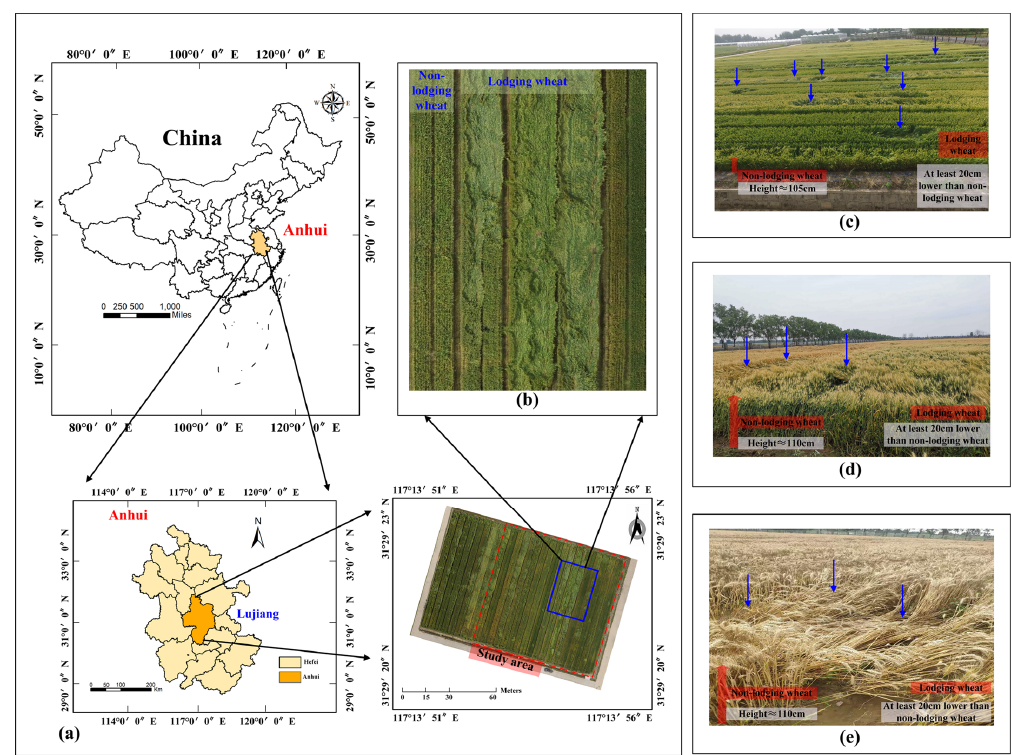
Figure 1. Location of UAV imaging area, study site and lodging samples: ( a ) study site; ( b ) partially enlarged display of the wheat field; the close-up maps of lodging and healthy wheat in ( c ) flowering, ( d ) filling and ( e ) maturity. The field indicated by the blue arrow is the lodging wheat.